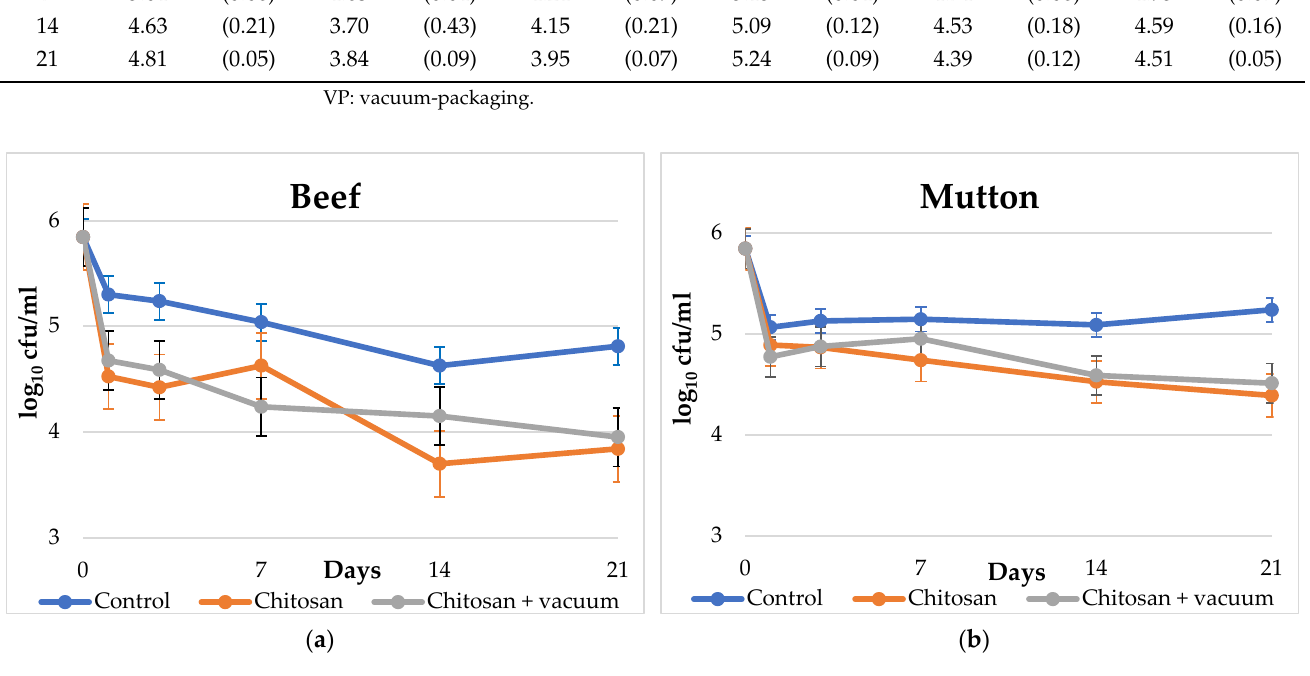
Figure 1. S. aureus populations during the storage of beef ( a ) or mutton ( b ) under refrigeration for 21 days. Table 1. S. aureus counts during the storage of beef or mutton under refrigeration for 21 days (aver- age values in bold and standard deviations in italics and parentheses; p ≤ 0.05).